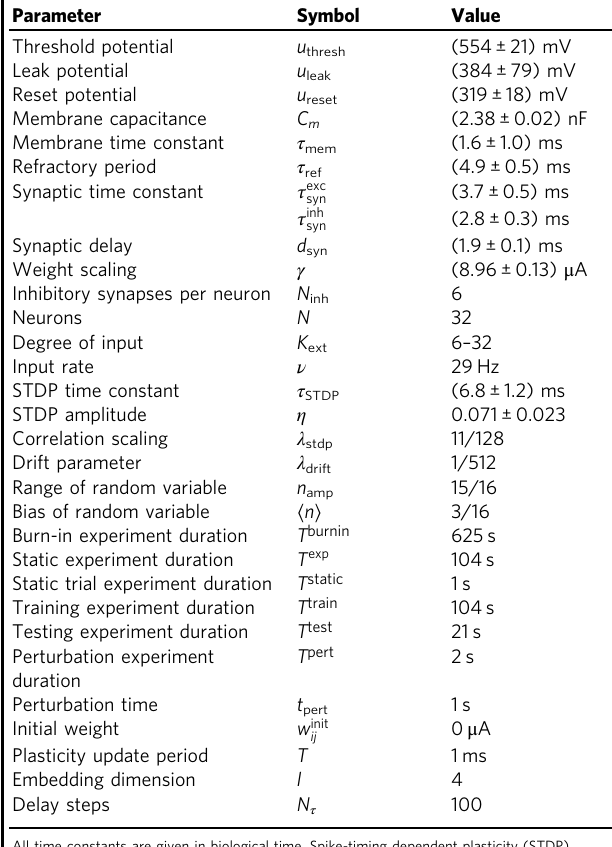
Table 1 Overview of the model